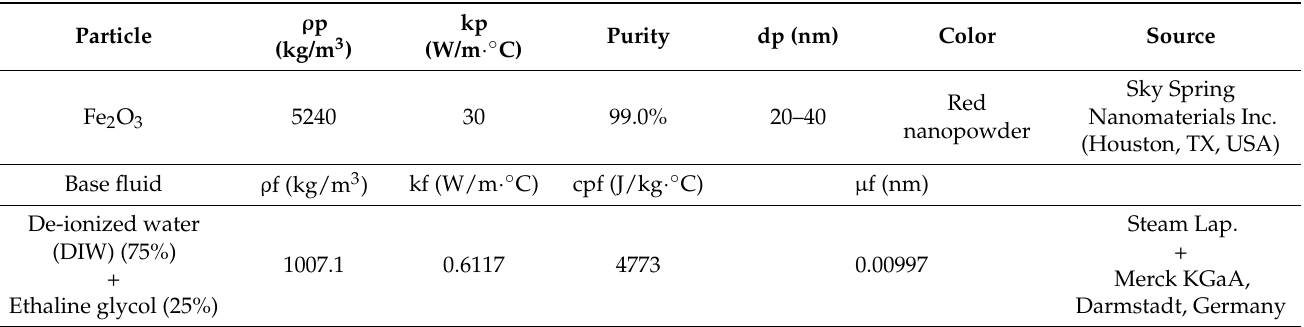
Table 3. Used material